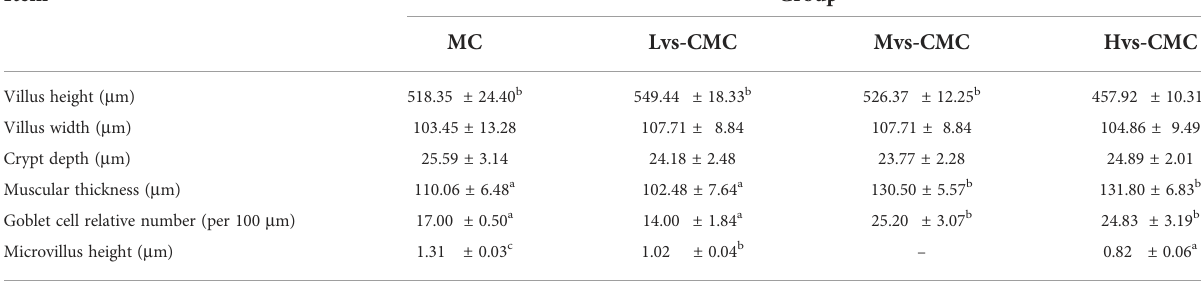
Values shown are the mean ± SEM (n = 4). Different superscript letters in the same row indicate signi fi cant difference between data (p < 0.05). MC, microcrystalline cellulose; Lvs-CMC, low-viscosity carboxymethyl cellulose; Mvs-CMC, medium-viscosity CMC; Hvs-CMC, high-viscosity